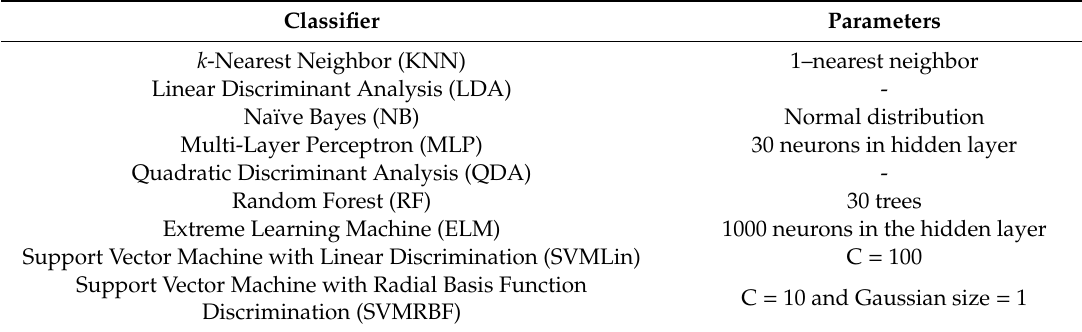
Table 3. Classifiers applied in this work and their